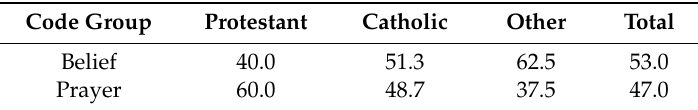
Table 15. Problems of ritual transfer—personal context—age. Code